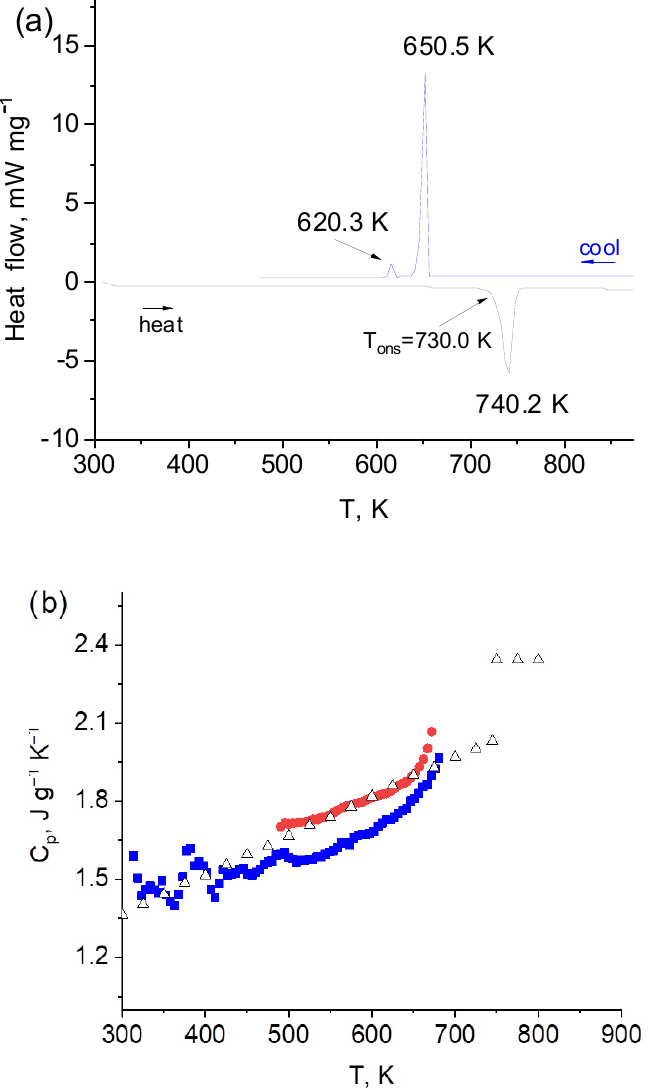
Figure 2. The DSC curves ( a ) and heat capacity ( b ) of Li 2 BeF 4 : ● —heating; ■ —cooling; △ —Douglas and Paine [6].